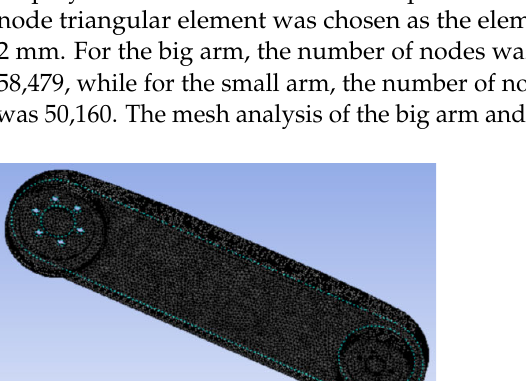
Figure 6. Finite element analysis model of the small arm. The limit state (that is, the horizontal position) was considered to fi nish the simula ‐ tion analysis, and the force analysis of the mechanical arm is shown in Figure 7. In Figure 7, G arm 1 and G arm 2 represent the gravity of the big arm and the small arm, respectively. G drive and G wrist represent the motor gravity and wrist gravity of the big arm and the small arm, respectively. F max is the maximum load that the robot arm can lift. According to the force analysis and to Ref. [9], the loads and constraints of the mechanical arms could be applied as shown in Figure 8. In Figures 7 and 8, A, B and C represent the joins of the robotic arms, and the details are as follows: A represents joint of fi rst and second links, B repre ‐ sents joint of second and third links, C represents joint of third and fourth links. Figure 7. Force analysis.